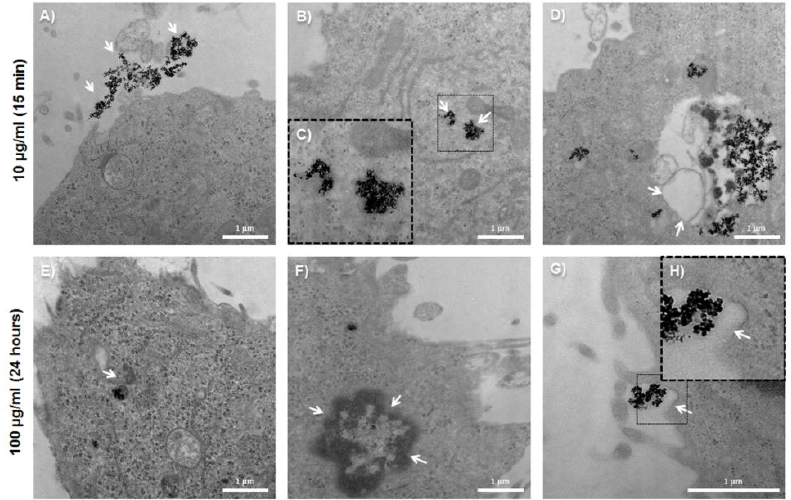
Figure 6. Transmission electron microscopy analysis of the BMNP internalization in colon cancer cells. Representative images the T-84 colon tumor cells showing extracellular ( A ) and intracellular ( B ) magnetic NPs (arrows). Magnification of the image ( C ) in which an outline around the intracellular BMNPs is shown, suggesting that it is inside a vesicle. Multivesicular body ( D ). Intracellular NPs surrounded by a membrane ( E ). Deteriorated cell nucleus ( F ). The dark border that is observed could be a sign of clathrin-mediated endocytosis ( G and H